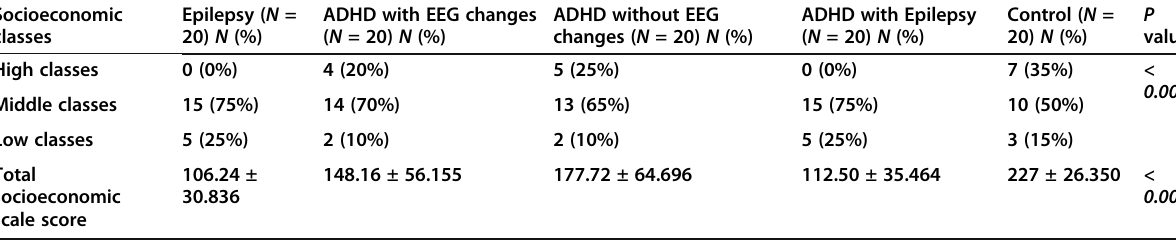
Table 5 Socioeconomic class scores among the studied groups Socioeconomic classes